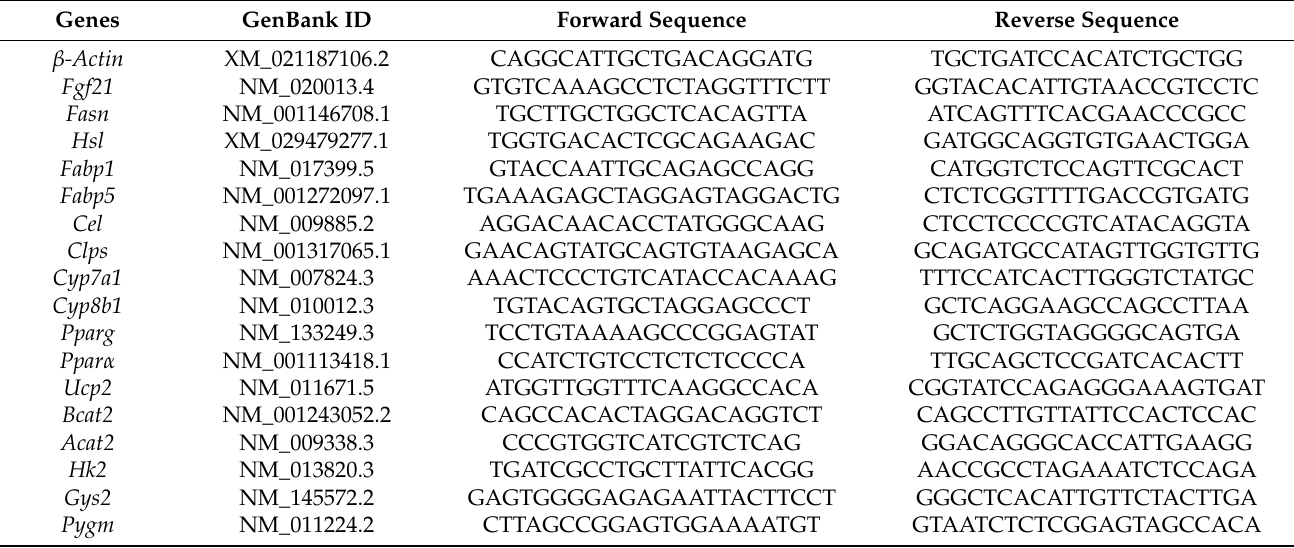
Table 3. Primer sequence for